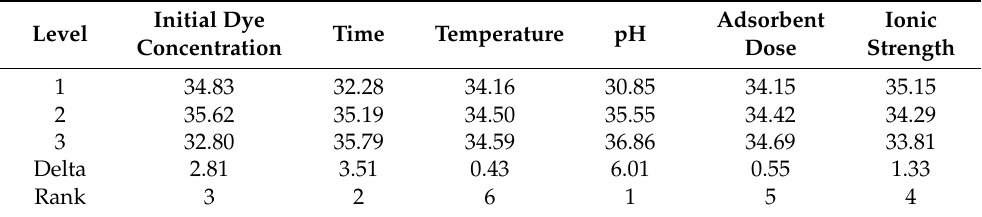
Table 7. Response table for signal-to-noise S/N ratios (larger is better).